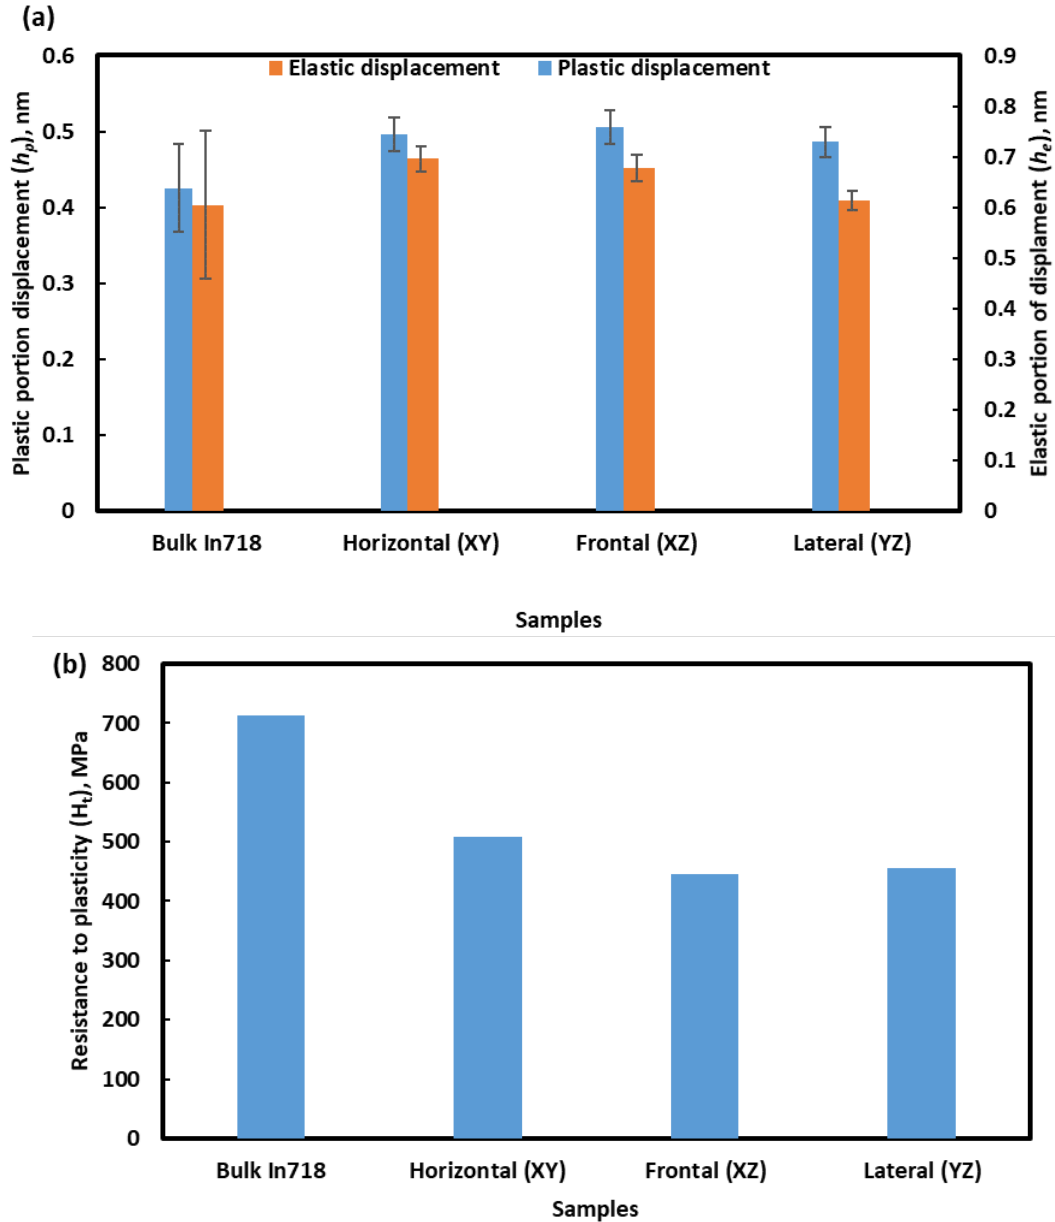
Figure 11. ( a ) Elastic ( h e ) and plastic ( h p ) displacements and ( b ) resistance to plasticity ( Ht ) of presently investigated Inconel 718 alloys.